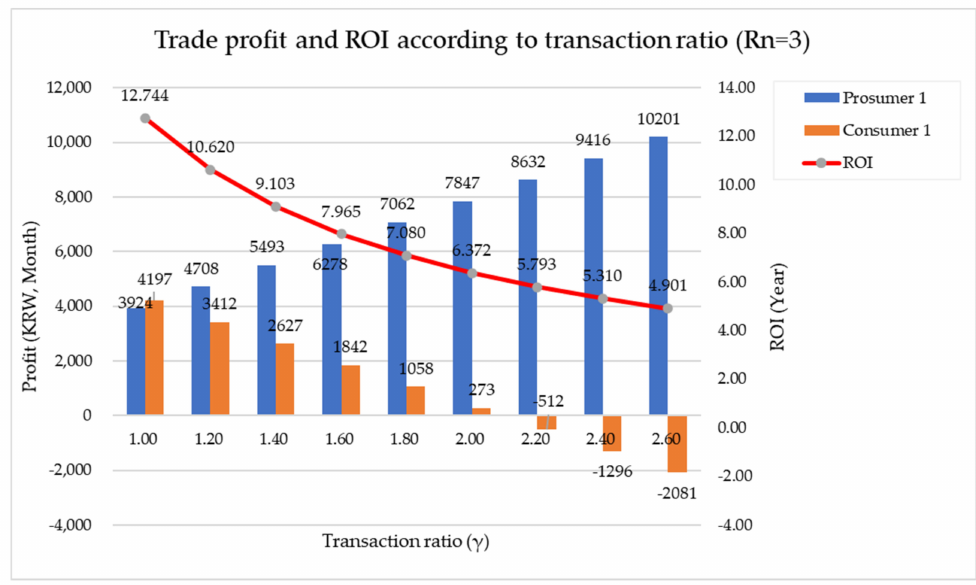
Figure 16. Transaction profit and ROI of Model 1 according to the change in γ .